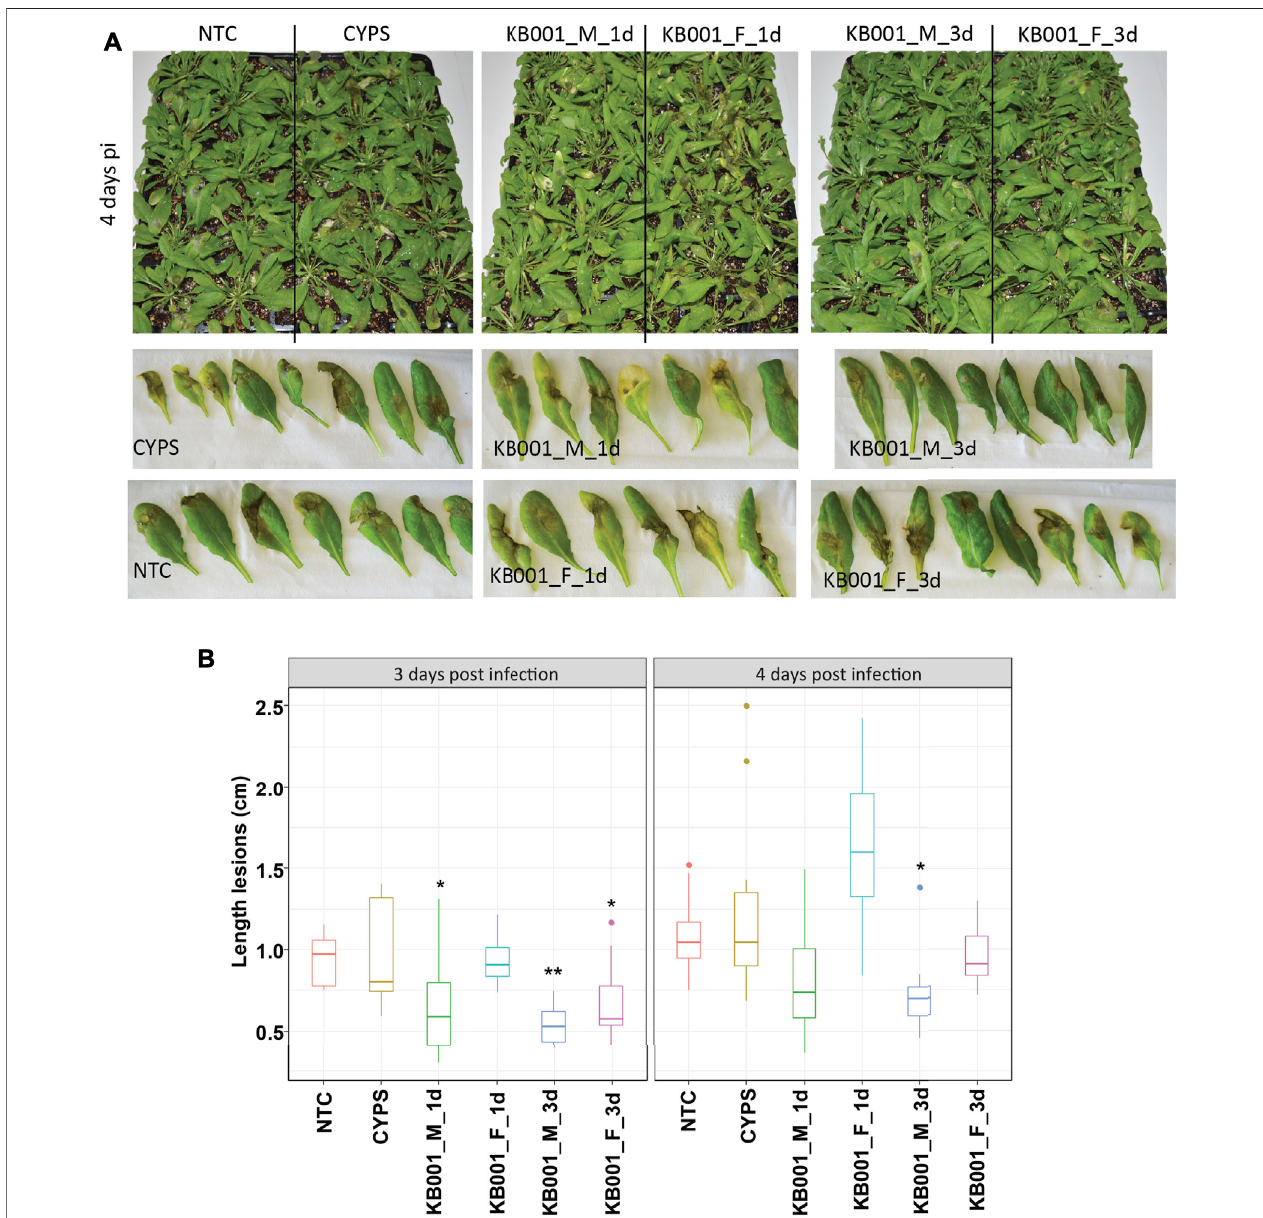
FIGURE 6 | Treatment of KB001 microbe culture improved resistance to Rhizoctonia solani infection. 4-week-old Arabidopsis plants were treated with the KB001 microbeorculture fi ltrate24 hand3 dayspriortoinfectionwith R.solani AG-2ZG5.Nontreated(NTC)andCYPS-treatedplantswereincludedasreferences.Severityof symptoms was determined by measuring necrotic lesions 3 and 4 days post-infection. (A) Representative leaves inoculated with R. solani 4 days post-infection. (B) ImageJ analysis of developed lesions in infected Arabidopsis plants. Shown is the average of 12 plants. A t -test was used to determine signi fi cant differences to CYPS samples. * p < 0.05, ** p < 0.01, *** p <